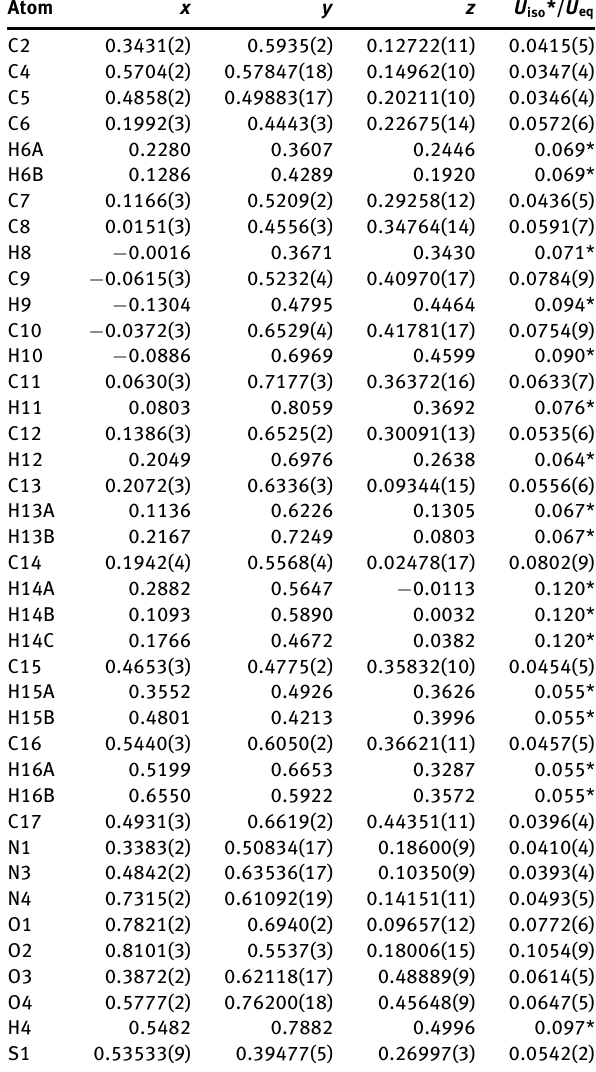
Table 2: Fractional atomic coordinates and isotropic or equivalent isotropic displacement parameters (Å 2